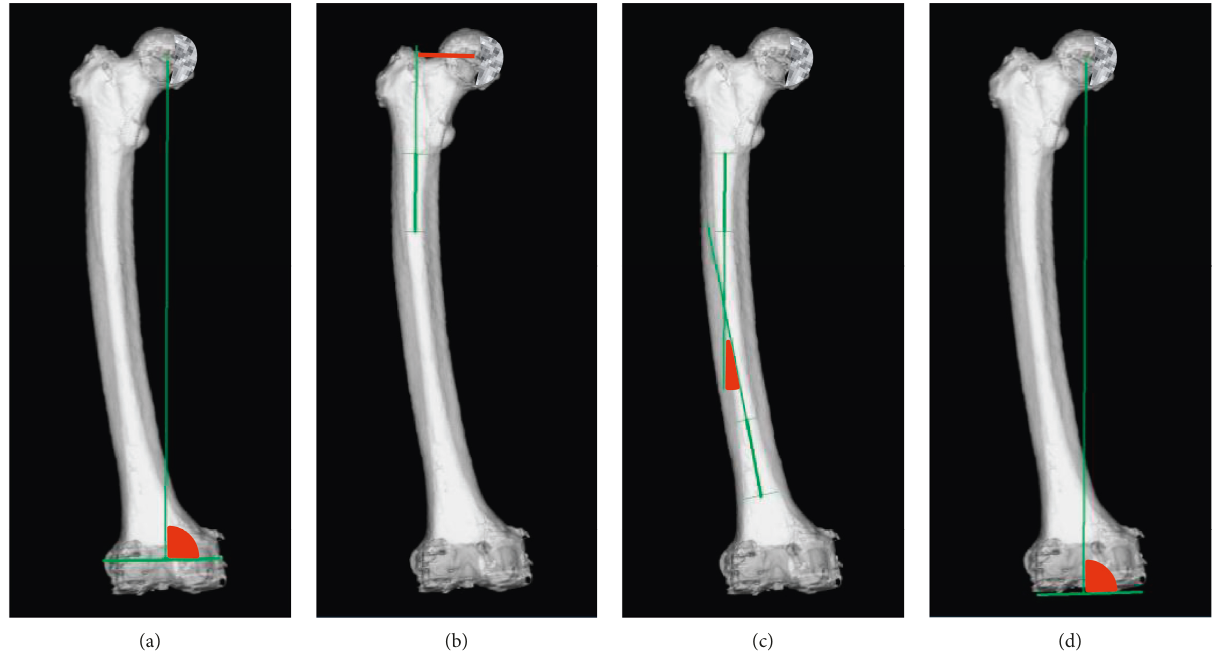
Figure 2: Shape of the proximal, middle, and distal femur in the coronal plane assessed by three-dimensional bone models. (a) MA-SEA angle, (b) femoral offset, (c) FBA, and (d) MA-DFC angle. MA–SEA angle: medial angle between the FMA and the SEA, FMA: femoral mechanical axis, SEA: surgical epicondylar axis, FBA: femoral lateral bowing angle, MA–DFC angle: medial angle between the FMA and the DFC, DFC: the line that connects the distal margins of the medial and lateral femoral